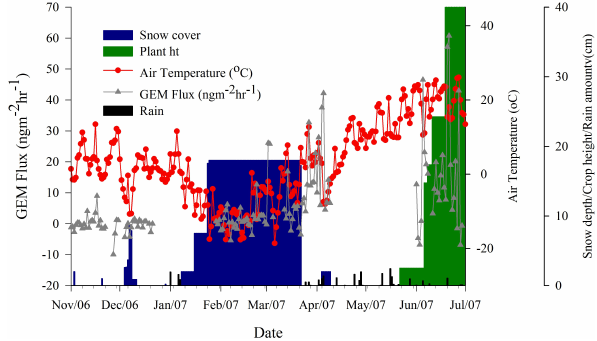
Fig. 11. GEM flux (ngm − 2 hr − 1 ), air temperature ( ◦ C), precipita- tion (mm) and crop cover (cm) with time (1 November 2006 to 29 June 2007) measured at Elora Research Station, ON. The days with snow cover and crop cover are